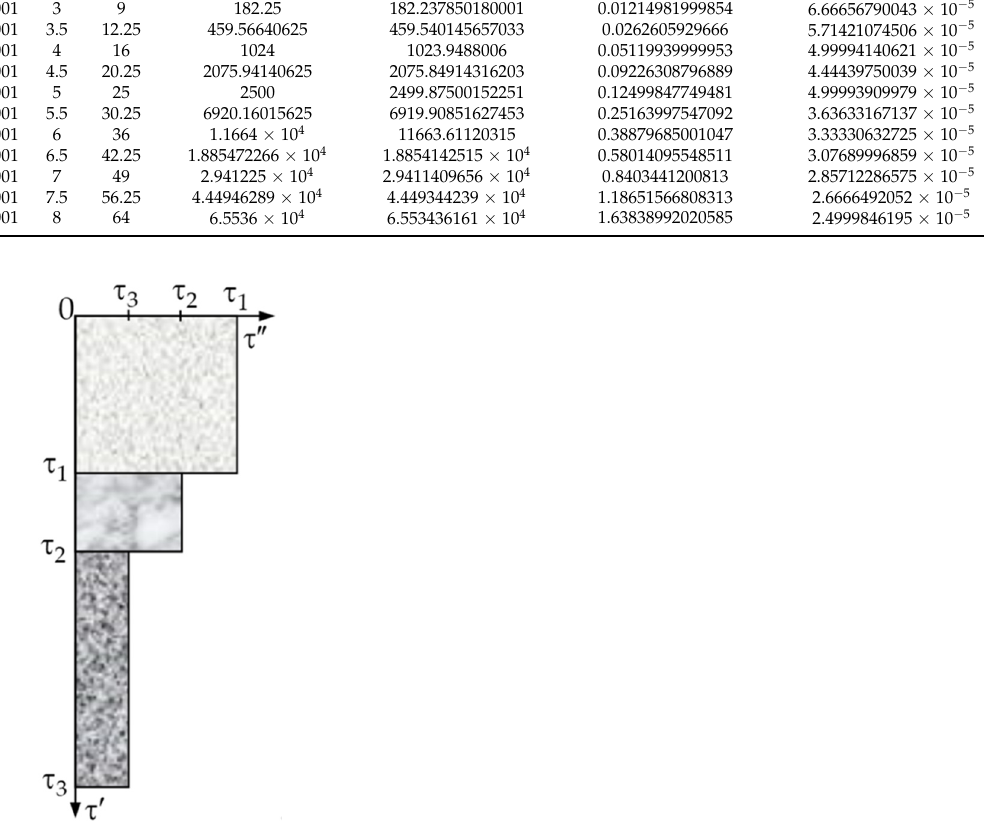
Figure 16. Schematic representation of set of integration regions in the points τ = τ 1 , τ = τ 2 , τ = τ 3 ( τ 1 < τ 2 < τ 3 ) for g( τ ) = 1 τ